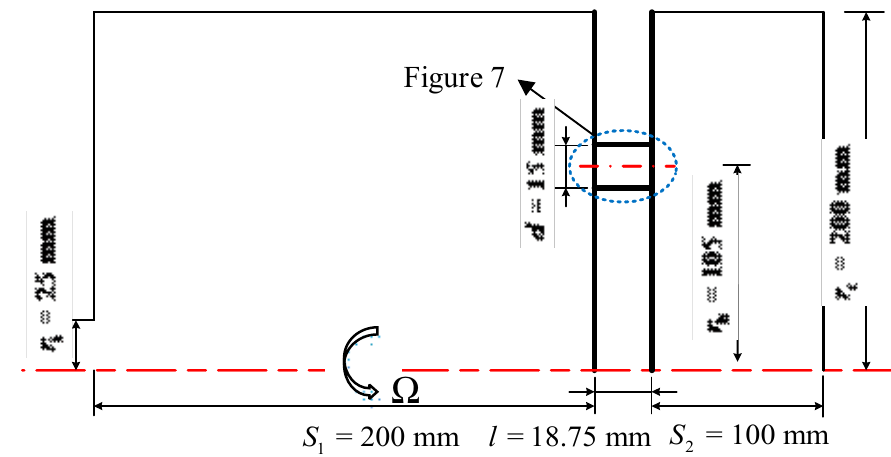
Figure 6. Geometry model of rotating straight through orifices.